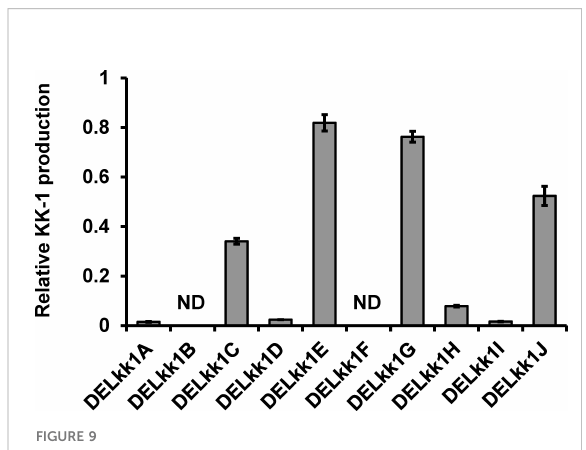
FIGURE 9 The relative KK-1 production of each cluster gene deletion strain when compared to that of the wild-type strain on day 7 of the culture. The abbreviations for the mutants are shown on the horizontal axis: kk1A deletion strain, DELkk1A; kk1B deletion strain, DELkk1B; kk1C deletion strain, DELkk1C; kk1D deletion strain, DELkk1D; kk1E deletion strain, DELkk1E; kk1F deletion strain, DELkk1F; kk1G deletion strain, DELkk1G; kk1H deletion strain, DELkk1H; kk1I deletion strain, DELkk1I; kk1J deletion strain, DELkk1J. The error bars represent standard deviations (three biological replicates). ND, not